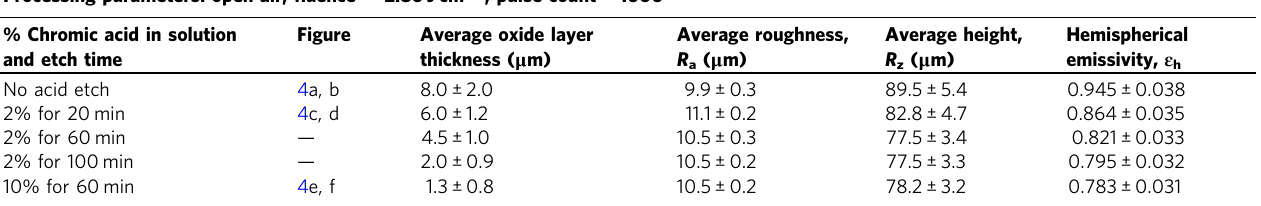
Table 2 Acid etching parameters with corresponding surface roughness parameters and emissivity for FLSP samples all produced using the laser parameters listed at the top of the